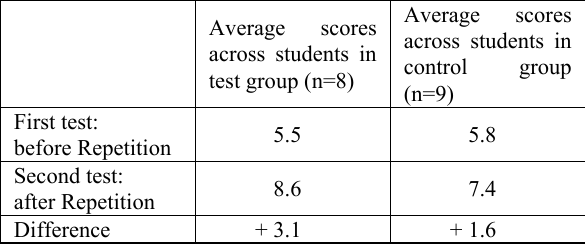
Table 3. Average scores across students in test and